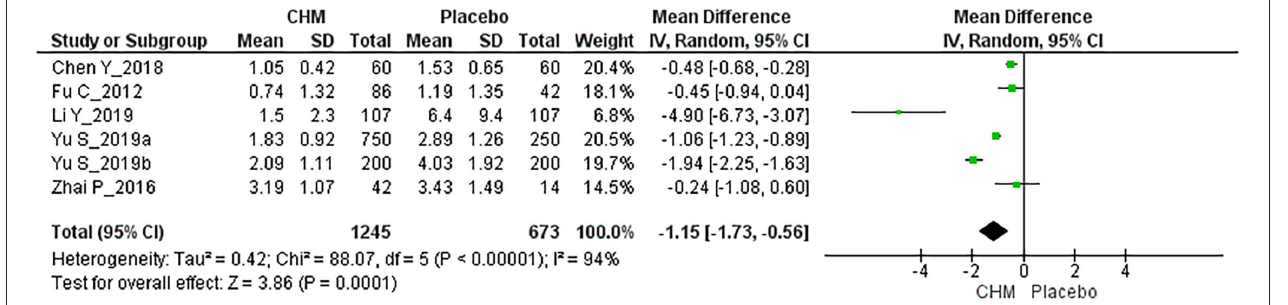
FIGURE 4 | Meta-analysis for migraine frequency at the end of